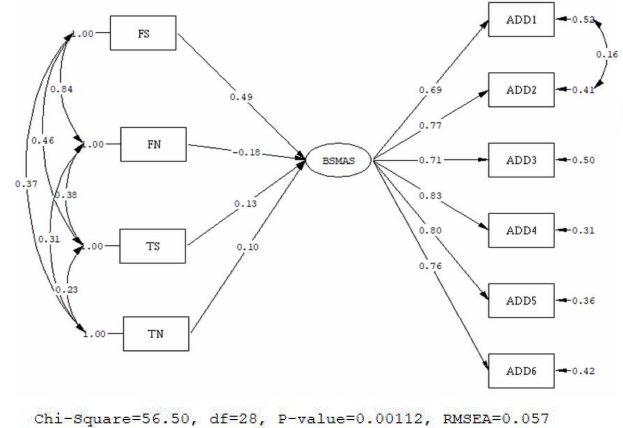
Figure 1. Multiple indicators multiple causes (MIMIC) model of the Bergen Social Media Addiction Scale (BSMAS). FS—frequency of Facebook Stories updates; FN—frequency of news feed updates; TS—time spent reading Facebook Stories; TN—time spent reading Facebook news feeds.